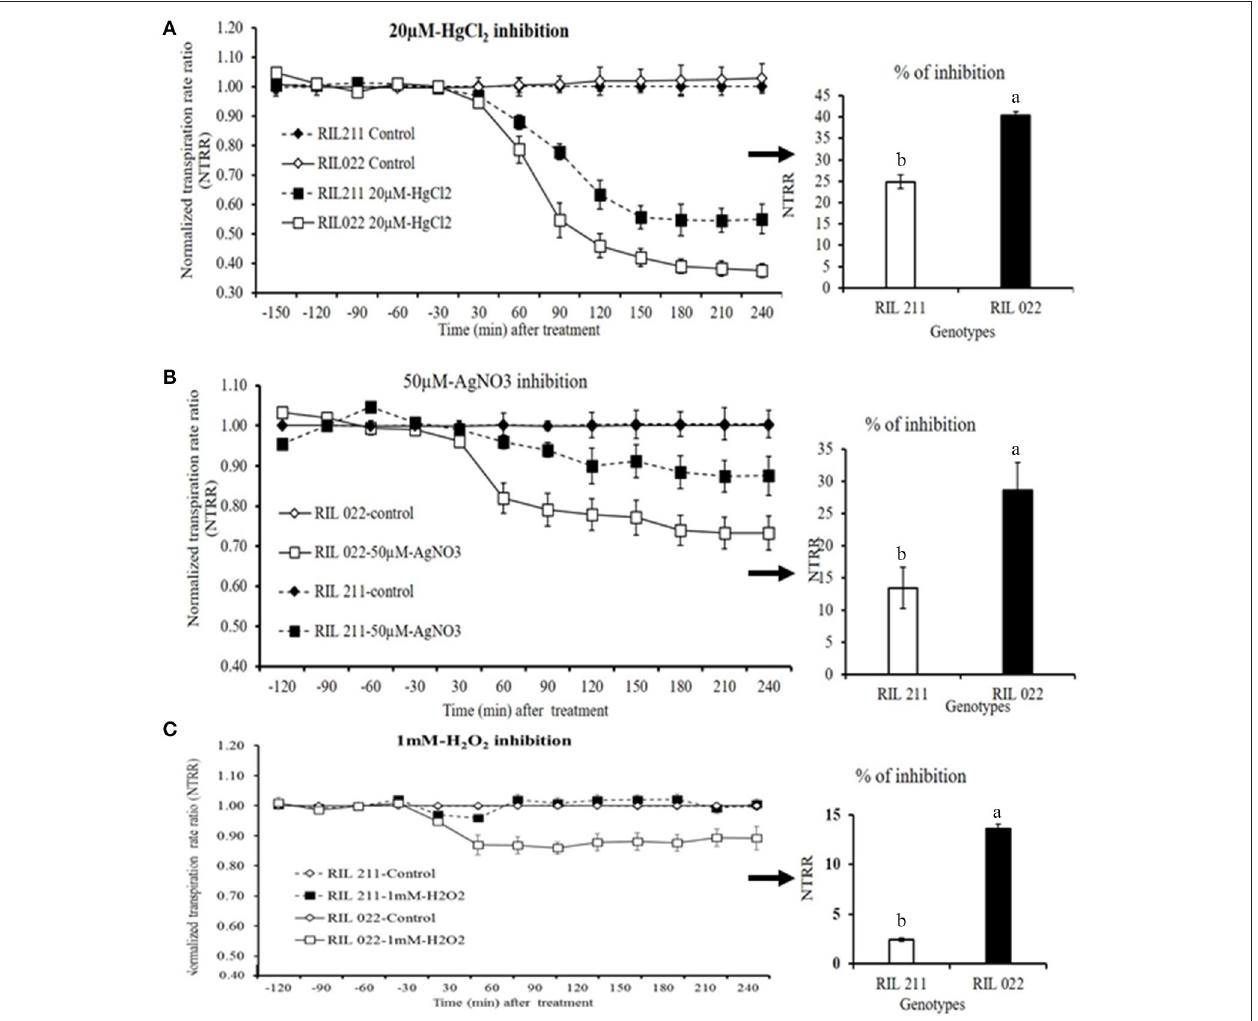
FIGURE 4 | Decline in transpiration of two chickpea genotypes contrasting for plant vigor in response to the aquaporin inhibitors 20 µ M-HgCl 2 , 50 µ M-AgNO 3 , and 1 mM-H 2 O 2 . The solid line with open square symbols represents RIL 022 and the dashed lines with closed square symbols represents RIL 211. The graph (A) represents the inhibition with 20 µ M-HgCl 2 and graph (B) represents the inhibition with 50 µ M-AgNO 3 . The graph (C) represents the inhibition with1 mM-H 2 O 2 . The arrows with respective bar graph represents % of inhibition (a, RIL 022; b, RIL 211), open bar represents ICC 4958 and closed bar represents ICC 1882. Bars with different letters are significantly different ( P = 0.05). Each treatment’s data points represent the NTRR means ( ± SE) of eight replicates per